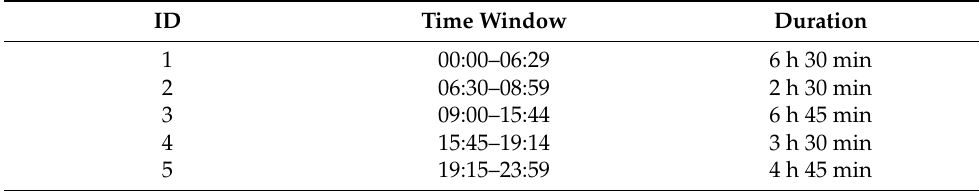
Table 1. Sub-daily time windows for total electrical